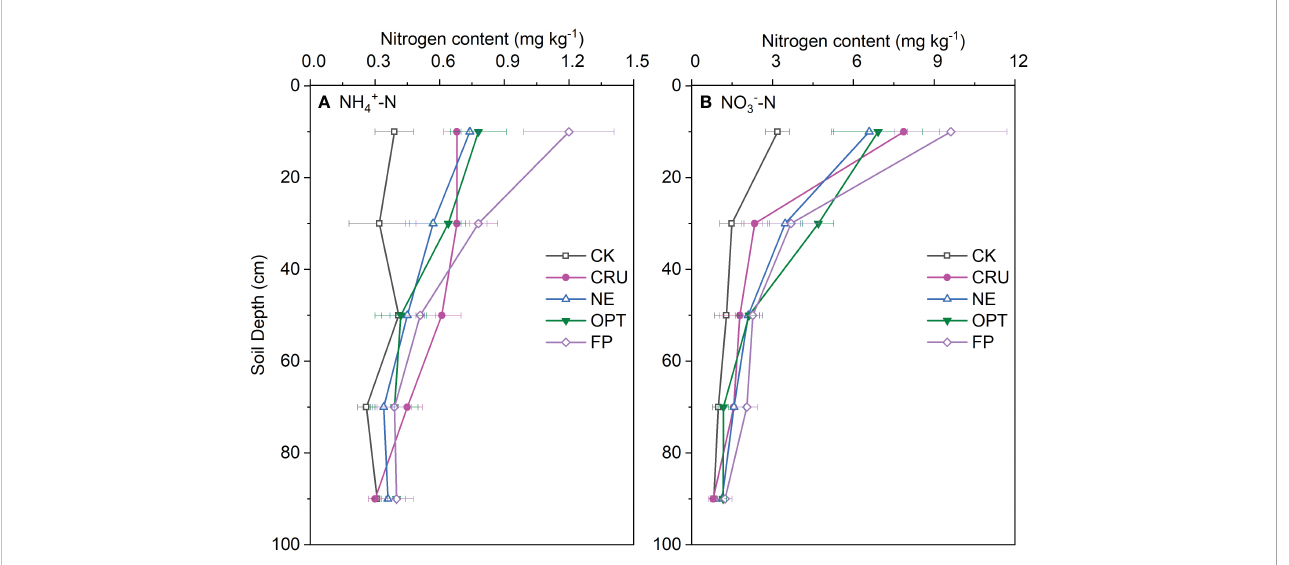
FIGURE 4 Vertical distribution of (A) NH 4+ -N and (B) NO 3 – N contents along the 0-100 cm depth soil pro fi le after paddy was harvested. The horizontal bars mean standard deviations of the means CK, zero nitrogen application; CRU, controlled-release urea application; NE, nitrogen expert-based fertilization application strategy; OPT, optimized nitrogen fertilizer application strategy recommended by local government; FP, farmer's experience-based nitrogen fertilizer application